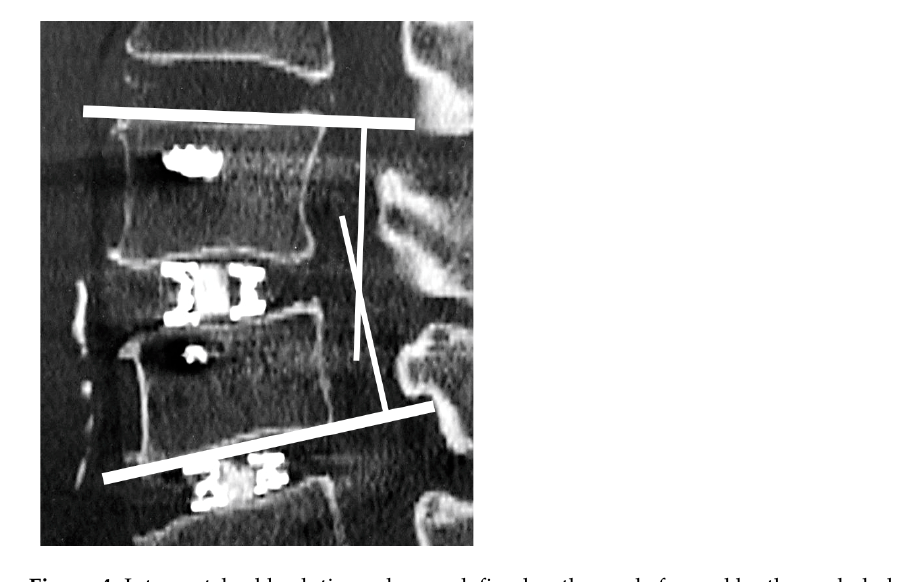
Figure 4. Intervertebral lordotic angle was defined as the angle formed by the cephalad endplate of the upper vertebra and the caudal endplate of the lower vertebra for each level.